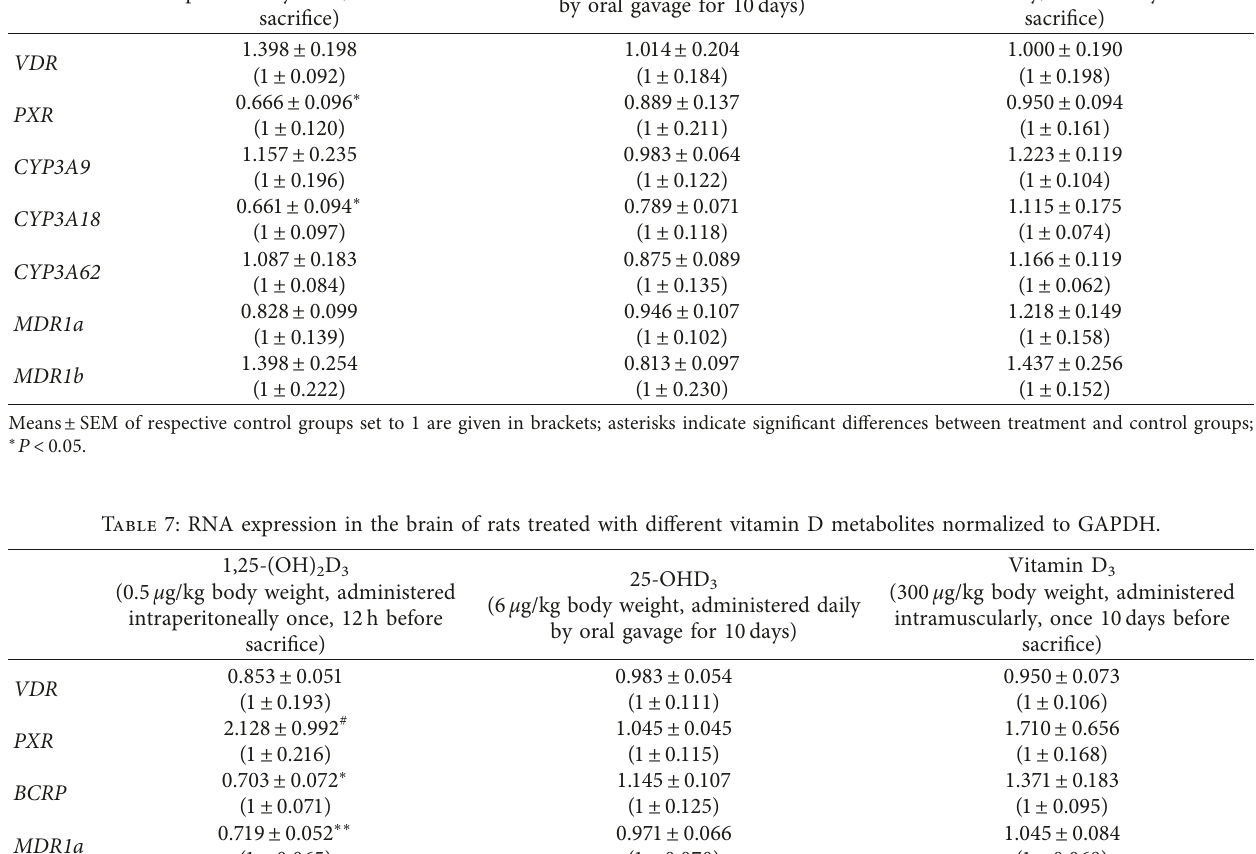
Means ± SEM of respective control groups set to 1 are given in brackets; asterisks indicate significant differences between treatment and control groups; # P � 0.053, ∗ P < 0 . 05, and ∗∗ P < 0 . 01.